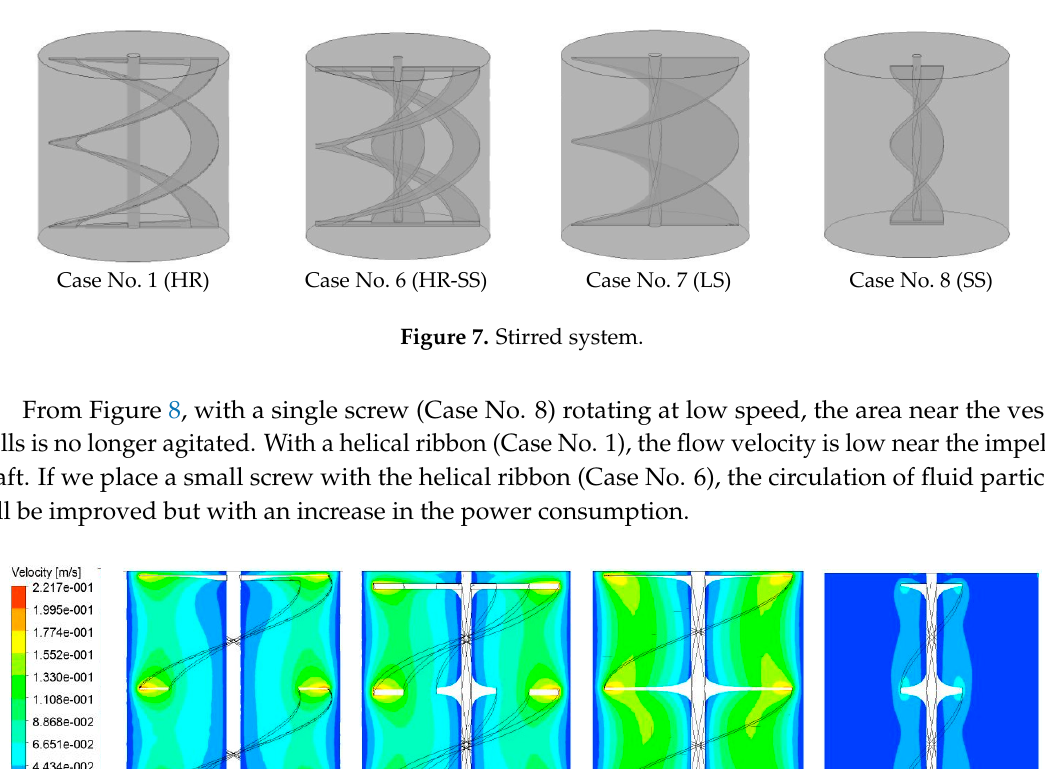
Figure 7. Stirred system. Figure 8. Velocity contours Re = 100, Z * = 0.5.